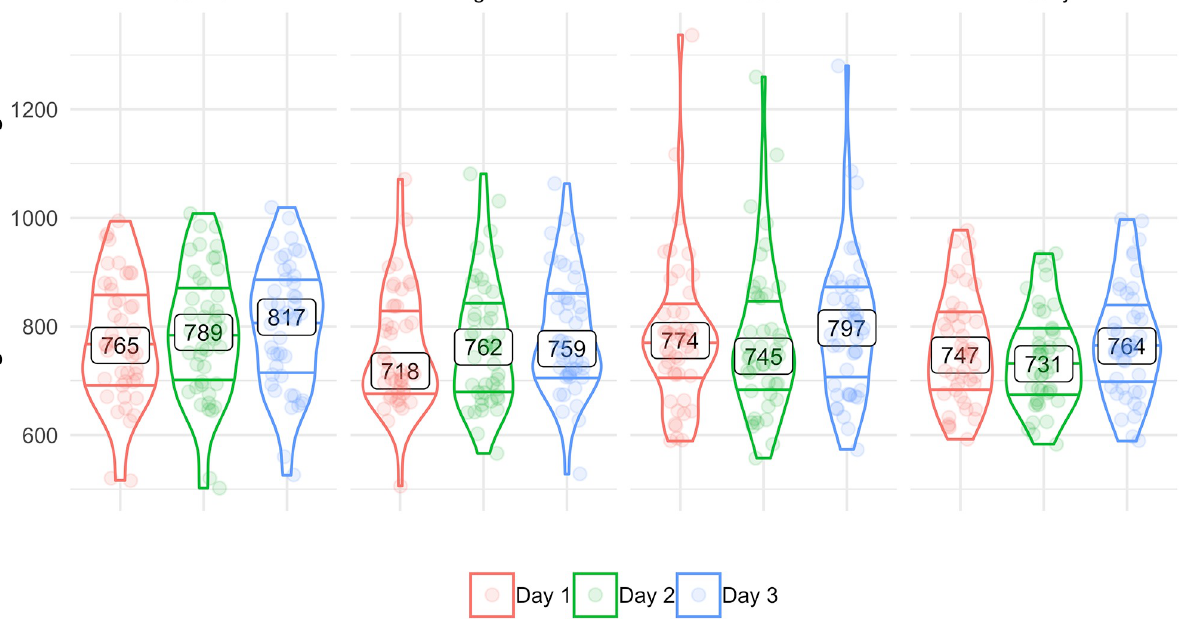
PLOS ONE | https://doi.org/10.1371/journal.pone.0255117 July 22,